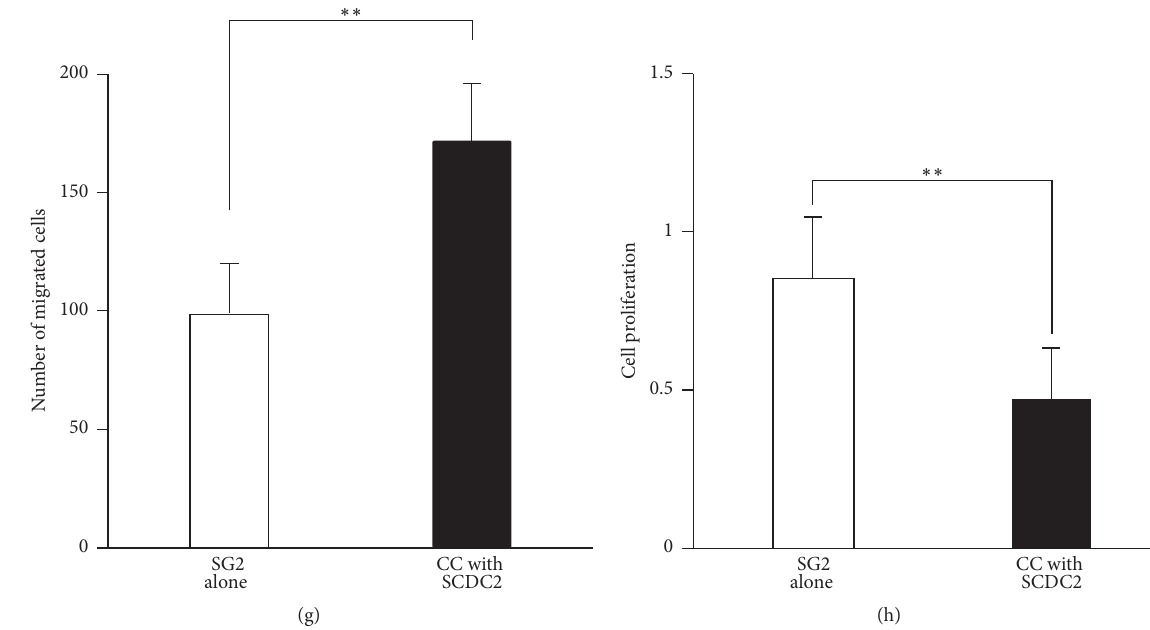
Figure 4: MSC stemness of SG2 cells is enhanced by direct coculture with SCDC2 cells. Cell-surface expression levels of SCA-1 (a), CD44 (b), and CD90 (c) were analyzed with each mouse-specific antibody in SG2 cells alone (blue), SG2 cells directly cocultured with SCDC2 cells (red), and an isotype control IgG (black) using flow cytometry. (d) SG2 cells were directly (CC) cocultured on the fixed feeder SCDC2 cells as described in Section 2. The SG2 cells were incubated in osteogenic (upper panel) or adipogenic (lower panel) induction medium. The cells were evaluated for extracellular matrix mineralization by alizarin red or lipid droplets by Oil Red staining. (e) Alizarin red was extracted with 10% cetylpyridinium chloride and absorbance was measured at 540 nm. (f) Oil Red O stain was extracted with DMSO and absorbance was measured at 540 nm. (g) The migratory ability of CC cocultured SG2 cells was investigated by a transwell migration assay. (h) The cell proliferation of CC cocultured SG2 cells was examined by a WST-1 assay. The results are expressed as the fold change relative to the respective control (SG2 alone). Data are presented as the mean ± standard deviation. ∗ 𝑃 < 0.05 , ∗∗ 𝑃 < 0.01